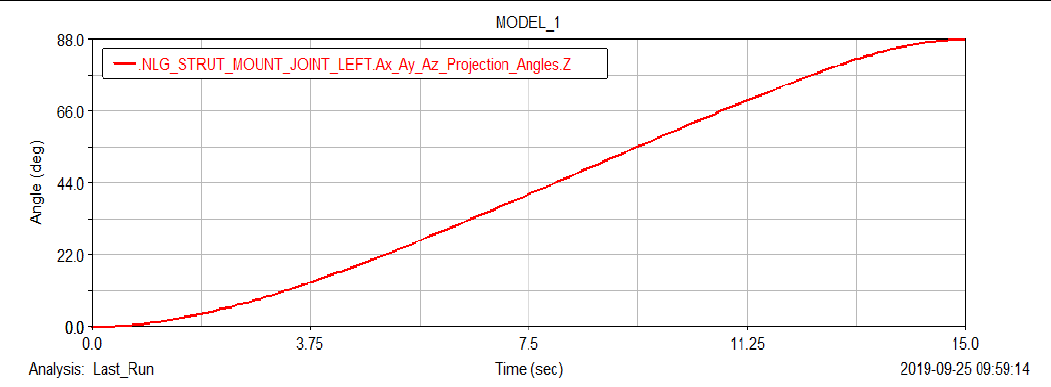
Figure 7. Computational result of retraction angle variation with time. This figure shows a total of 15 s are required for complete retraction of landing gear by 88